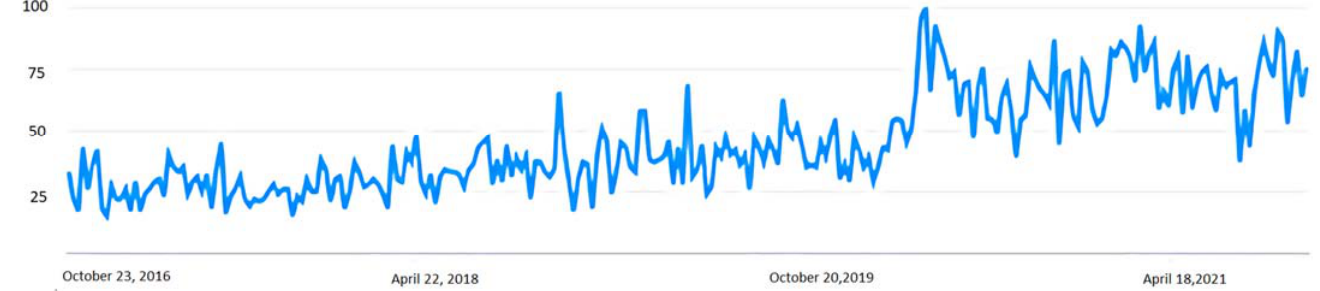
Figure 2. Number of searches for the term “meditation” between 2016 and 2021 in Spain. Source: Google Trend